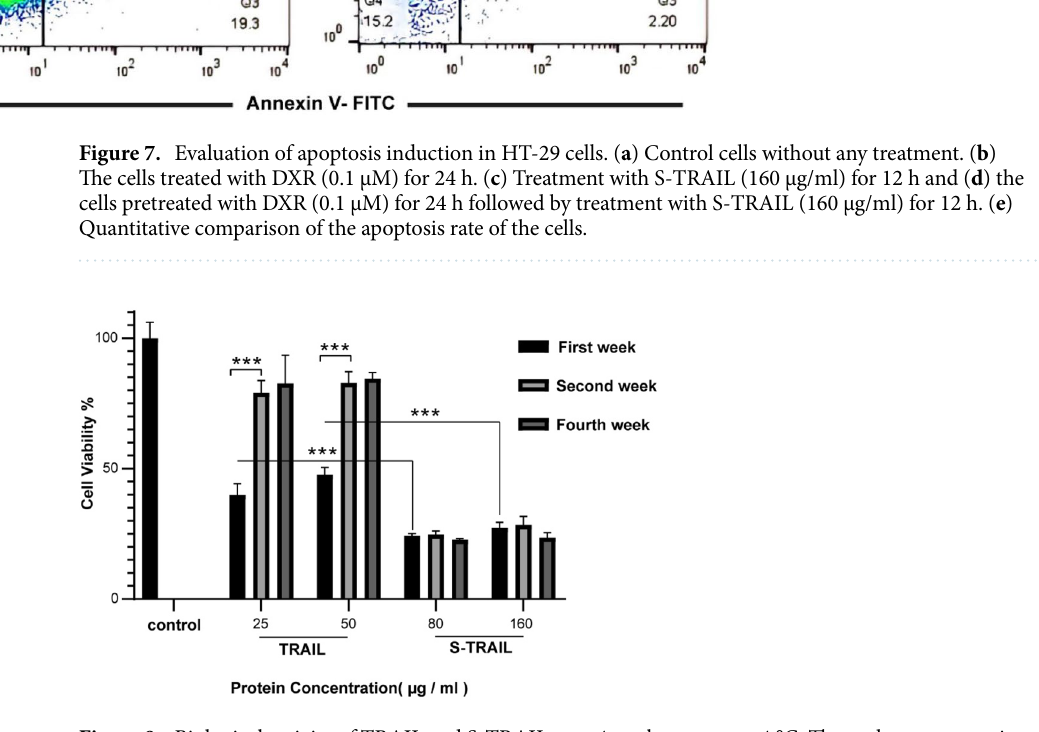
Figure 8. Biological activity of TRAIL and S-TRAIL over 4 weeks storage at 4 °C. The molar concentration of 25 and 50 µg/ml of TRAIL protein are equal to the molar concentration of 80 and 160 µg/ml of S-TRAIL, respectively. Statistical significance was evaluated by repeated ANOVA test and student t-Test. ∗ p < 0.05, ∗∗ p < 0.01, ∗∗∗ p < 0.001